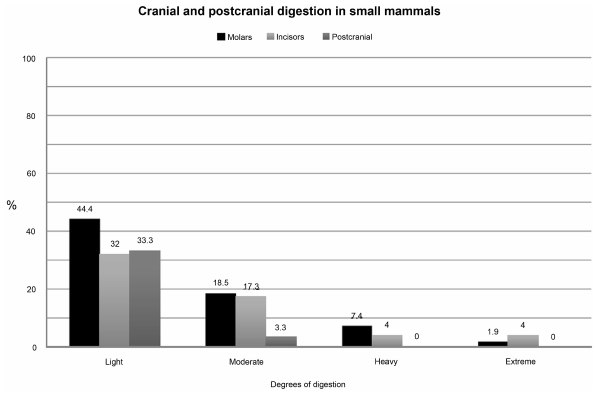
Fig. 5. Percentages of small-mammal elements from Canyars show- ing different degrees of digestion. We identify 4 degrees of di- gestion, from light to extreme, following the method of An- drews (1990) for incisors and molars, and the method of Fern´andez- Jalvo (1992) for postcranial elements. There are some elements that could not be classified to their degree of digestion, because they were not digested. There are the 27.8% of molars, the 42.7% of incisors and the 63.4% of postcranial